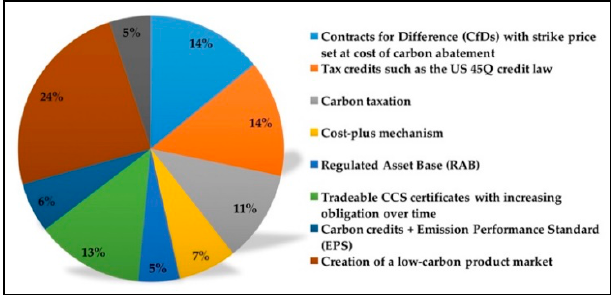
Figure 12. Stakeholder preferences for supportive revenue mechanisms of CCUS steel projects.